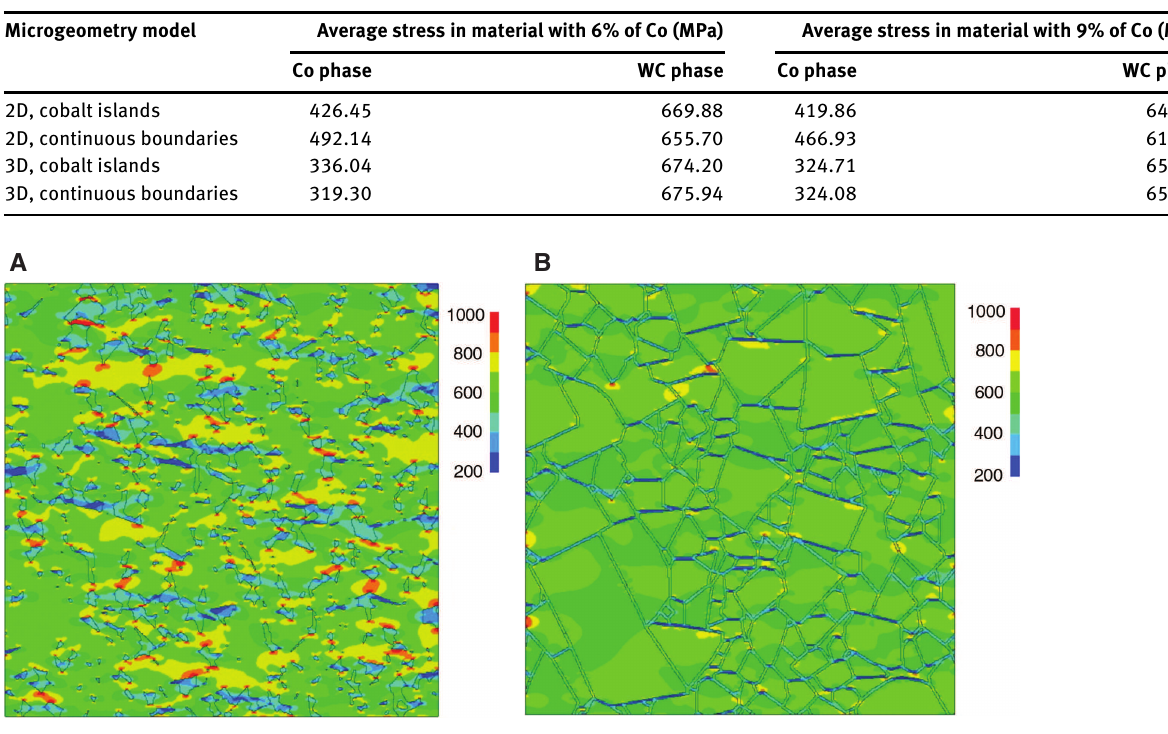
Figure 18: Stress field obtained on the basis of 2D microgeometry containing (A) cobalt islands and (B) continuous boundaries between the tungsten carbide particles (MPa).